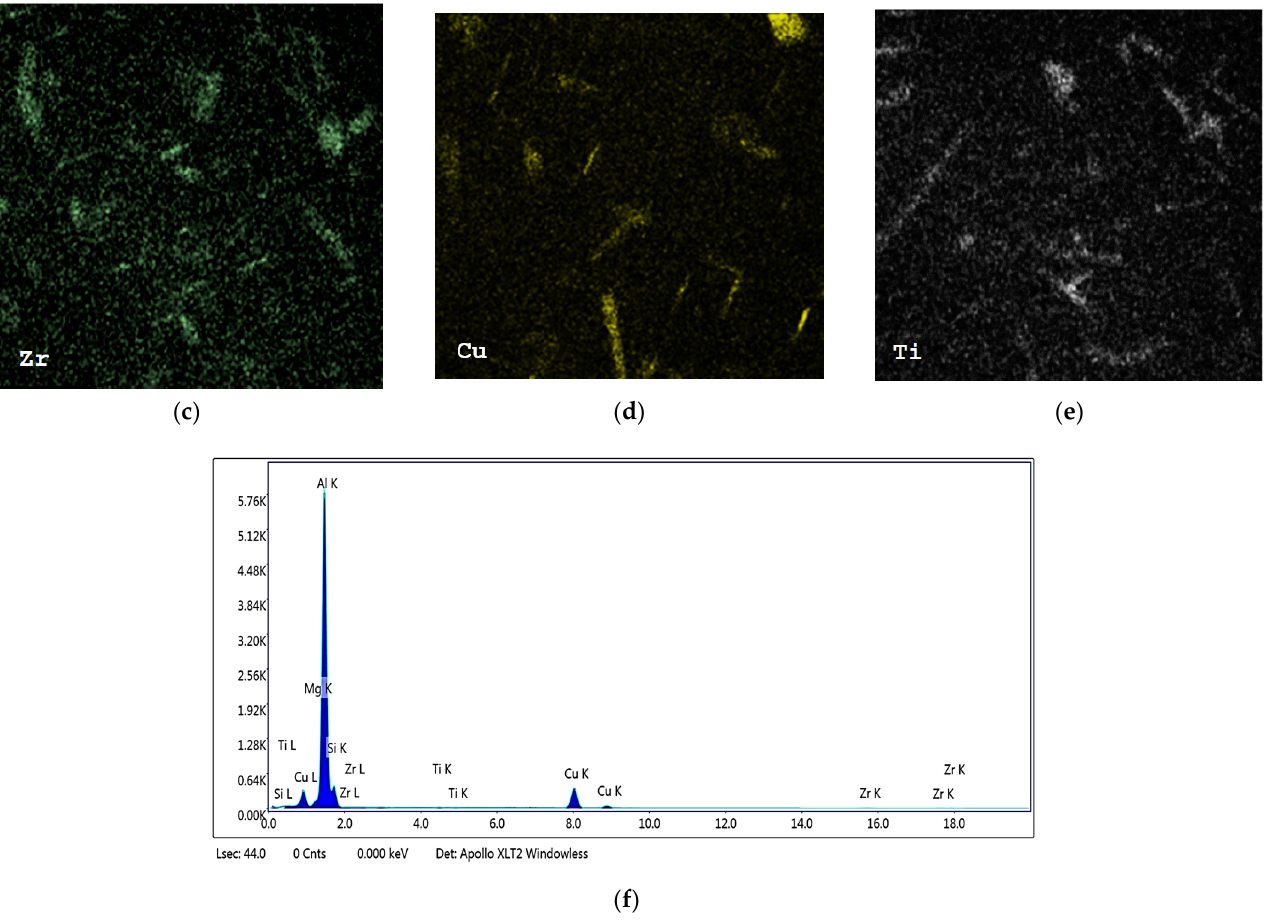
Figure 15. TEM bright-field electron micrographs of 354 alloy containing 0.39%Zr and 0.17%Ti and aged at ( a ) 155 °C/100 h—at 60,000× magnification; ( b ) 220 °C/100 h—at 150,000× magnification; ( c – e ) X-ray images of ( c ) Zr, ( d ) Cu, and ( e ) Ti distribution in ( b ); ( f ) EDS spectrum corresponding to ( b ). Black arrows point to Ti-containing phase, white arrows point to Al 2 Cu phase, and orange arrows point to Al 3 Zr phase in ( b ).